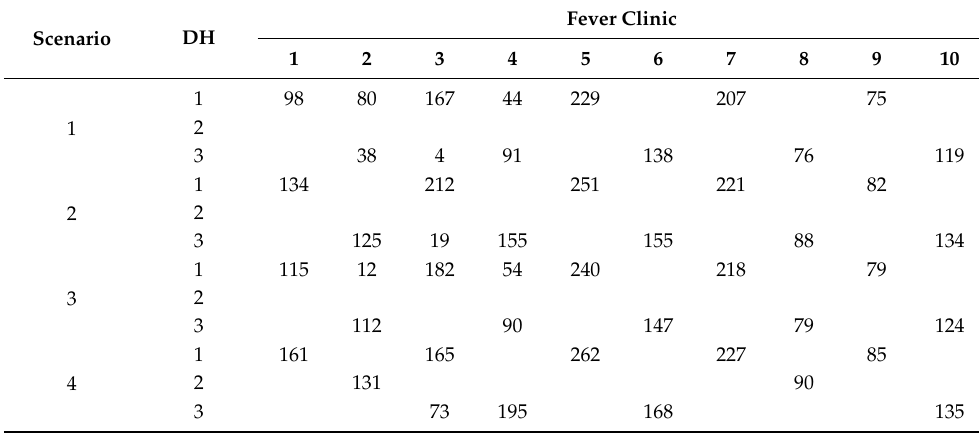
Table 9. Critical patients transferred from each fever clinic to established